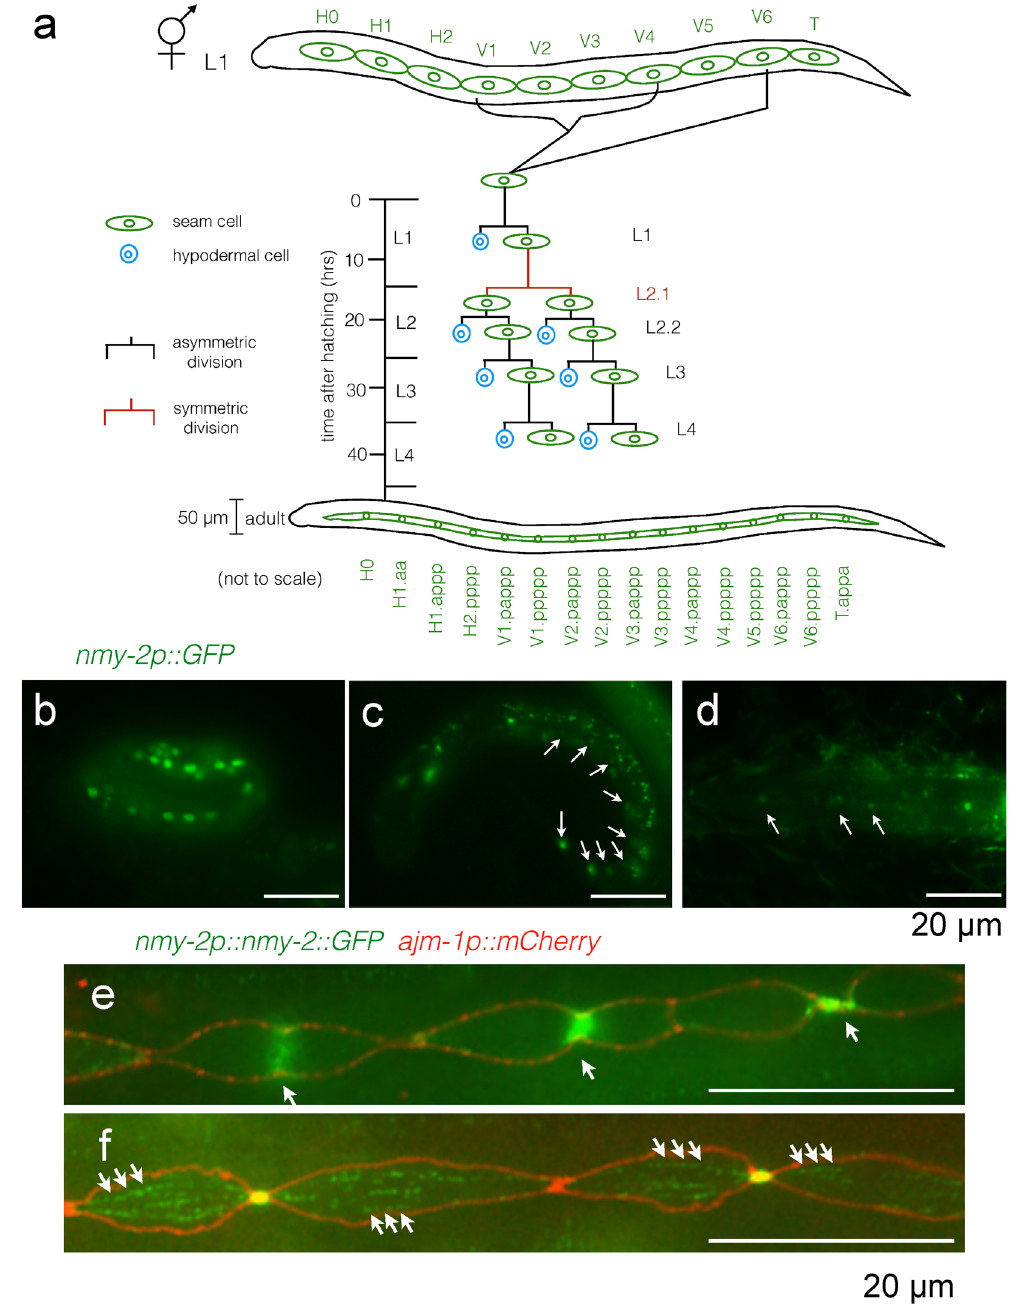
Figure 1. nmy-2 is expressed in the seam. ( a ) Hermaphrodite lineage diagram of the V seam cells (V1-4, V6). Seam cells are green and differentiated hypodermal cells are blue. The worms hatch with ten seam cells on each side. The V lineage cells undergo L1, L2.2, L3 and L4 asymmetric divisions (white lines) as well as the L2.1 symmetric division (brown lines) during larval development to generate a total of 16 terminal seam cells per side, which fuse to form a seam syncytium in adulthood, whilst contributing hypodermal cells to the hyp7 syncytium to allow the worm to grow in size. The adult worm is not drawn to scale compared to the size of the L1 larva. ( b – d ) The nmy-2 transcriptional reporter (strain AW1118) shows seam-specific expression in the ( b ) three-fold embryo, ( c ) L1 larva, and ( d ) L2 larva. Arrows point to seam cells. ( e , f ) The nmy-2 translational reporter with an integrated apical junction marker ( ouIs21 [ ajm-1p::mCherry ]) (strain AW1092) shows that NMY-2 localises to the cytokinesis furrow (arrows in e ) and to punctae forming fibre-like structures (arrows in ( f ). ( e ) Shows a larva undergoing the L3 division, and ( f ) is a larva that had just completed the L4 division. Larvae performing the L2.2 asymmetric division showed similar expression patterns and are omitted for simplicity. As for all the microscopy images here and henceforth, anterior is to the left, posterior is to the right, dorsal is on the top, and ventral is on the